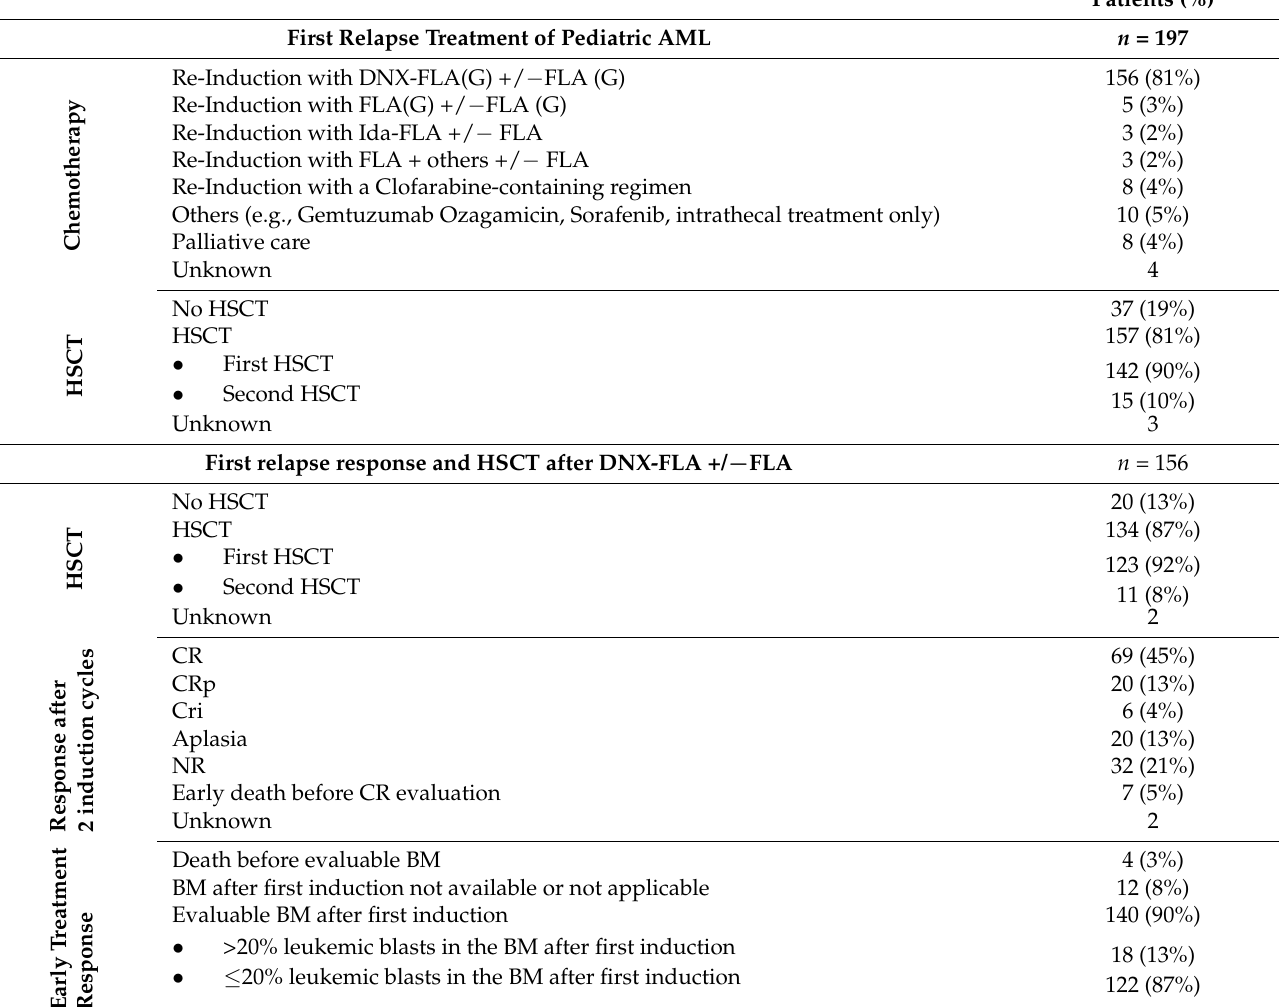
Table legend: For categories including patients with unknown status, percentages are calculated without “unknown”. Abbreviations: CR, complete remission; CRp, complete remission with partial regeneration; Cri, complete remission with incomplete recovery; DNX, liposomal daunorubicin; FLA(G), fludarabine, cytarabine with or without granulocyte colony-stimulating factor; HSCT, hematopoietic stem cell transplantation; NR, nonresponse. See Table S1 for